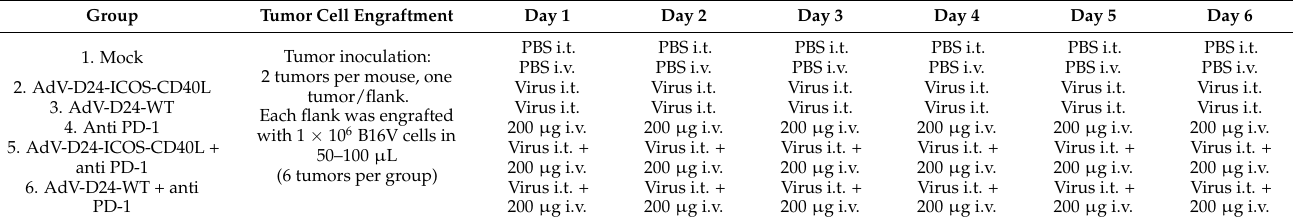
Table 1. Overview of the treatment scheme. i.t: intratumorally; i.v: intravenously; ICOSL: inducible co-stimulator ligand.